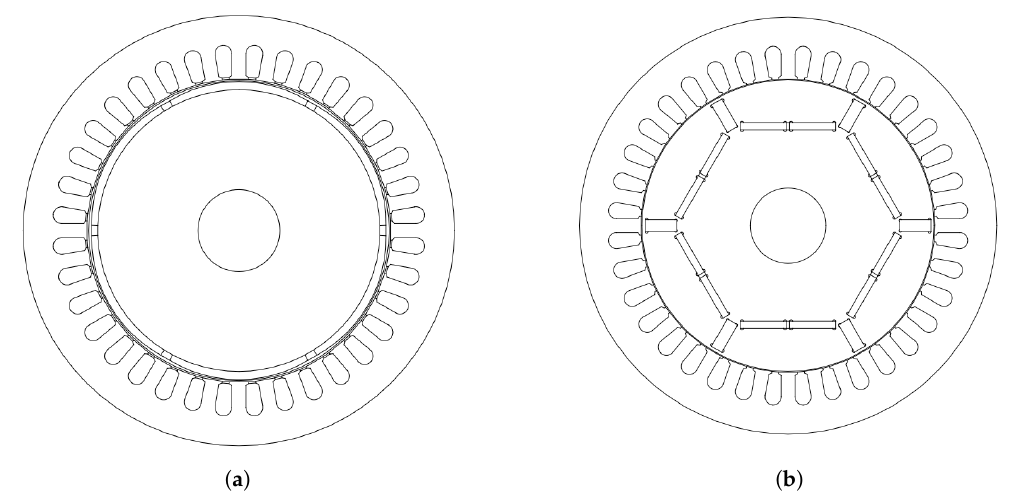
Figure 2. 2D geometry of: ( a ) reference surface permanent-magnet synchronous machine; ( b ) proposed Interior Permanent-Magnet Synchronous